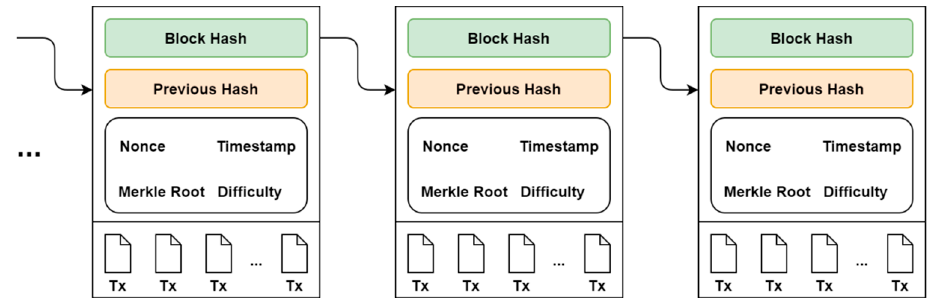
Figure 2. A simplified Blockchain Structure.